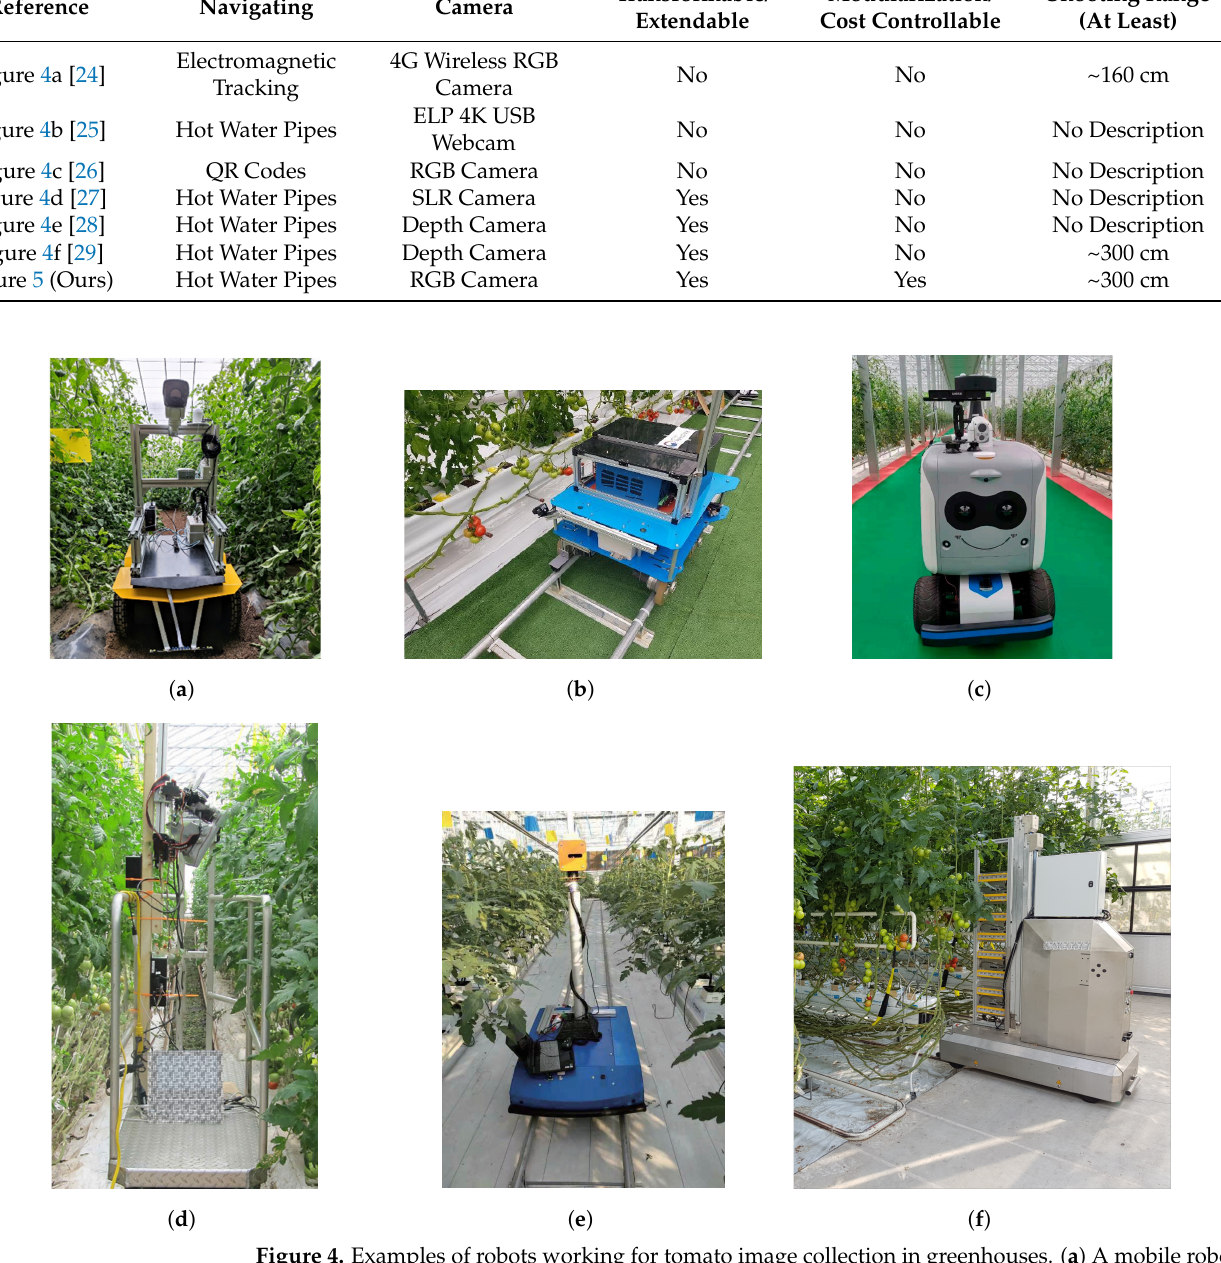
Figure 4. Examples of robots working for tomato image collection in greenhouses. ( a ) A mobile robot with a 4G wireless camera [24]; ( b ) a mobile robot featuring a 4K camera [25]; ( c ) a mobile robot with multiple sensors, including cameras [26]; ( d ) a mobile platform equipped with a linear actuator. Adapted with permission from [27]. 2016, Elsevier; ( e ) a scouting robot fitted with a depth camera. Adapted with permission from [28]. 2021, IEEE Xplore; ( f ) a mobile robot fitted with four depth cameras [29]. ( a – c ) are fixed mechanical structures. ( d , e ) have some extension capability. ( f ) can cover most of the tomatoes by raising the